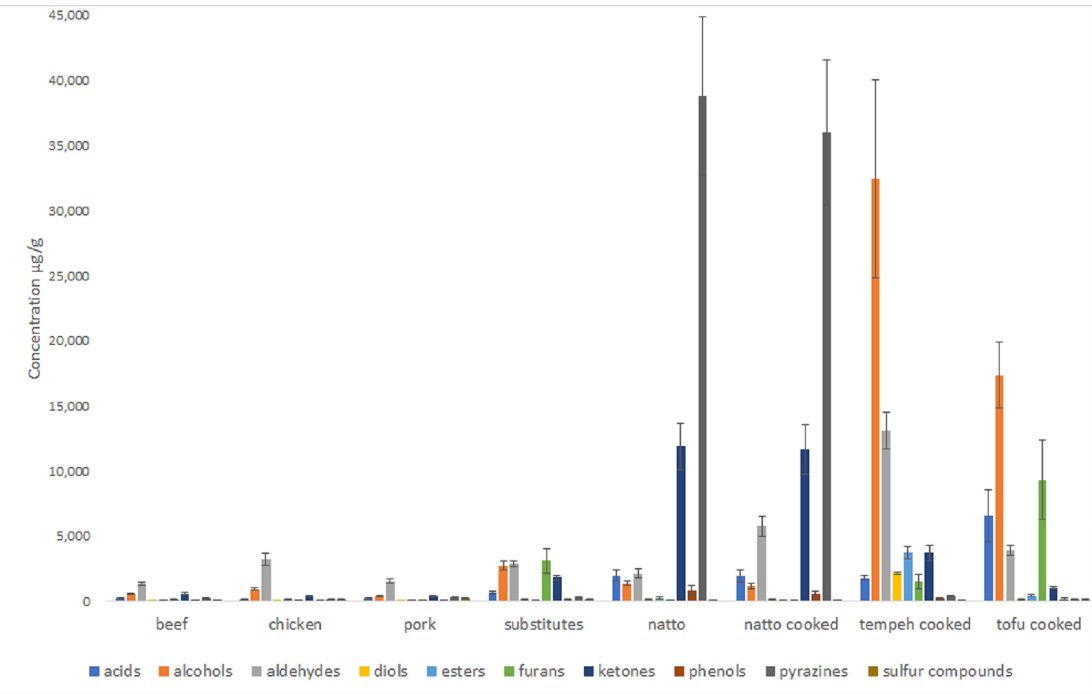
Figure 1. Volatile profile of meat, meat substitutes, natto, tempeh, and tofu according to chemical class. The concentration of each compound is normalized and calculated based on the internal standard (4-methyl-1-pentanol) assuming a response factor equal to one for all